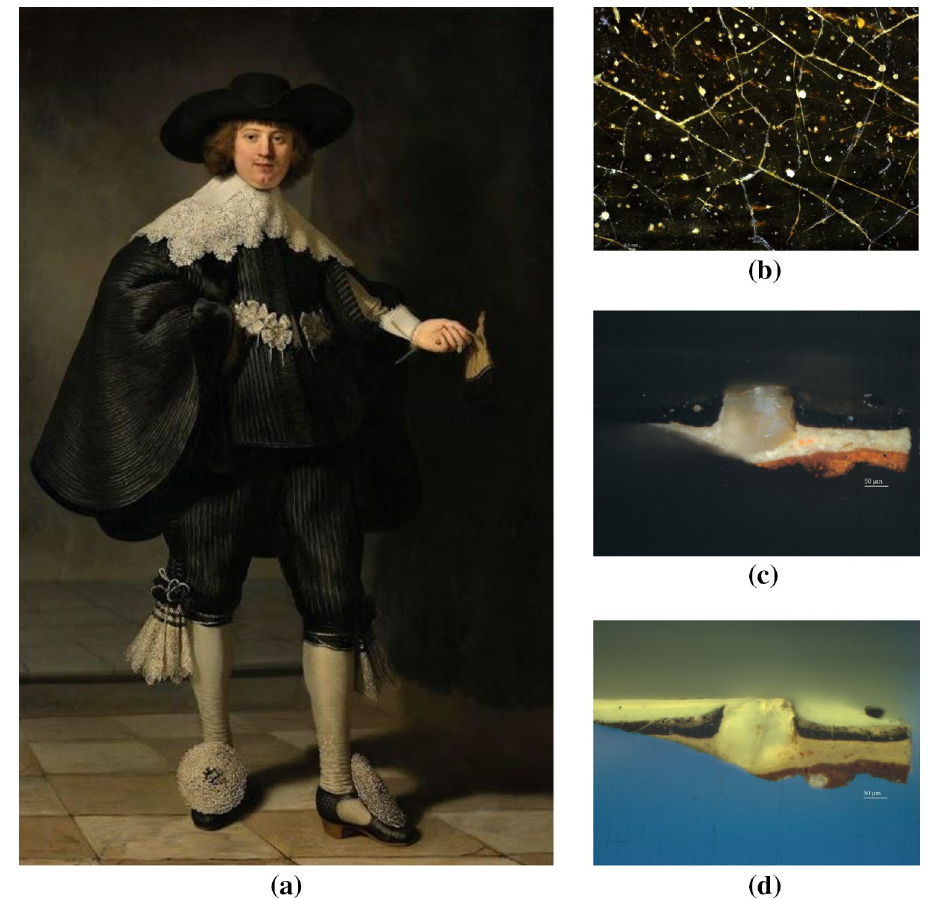
Fig. 1 a Rembrandt van Rijn, Portrait of Marten Soolmans, 1634, oil on canvas, 207.5 cm x 132 cm, Rijksmuseum, Amsterdam, The Netherlands. After treatment. b Micro-detail of the painting (before treat- ment) showing tiny whitish globules of lead soaps protrud- ing through the black paint surface. c , d A paint cross- section is taken at the top left of the painting, showing a large metal soap protrusion (diameter circa 150 𝜇 m). The light microscopic images of the metal soap aggregate are taken under c normal light illumination (bright field) and d ultraviolet illumination (365 nm). See [6]. Photos: